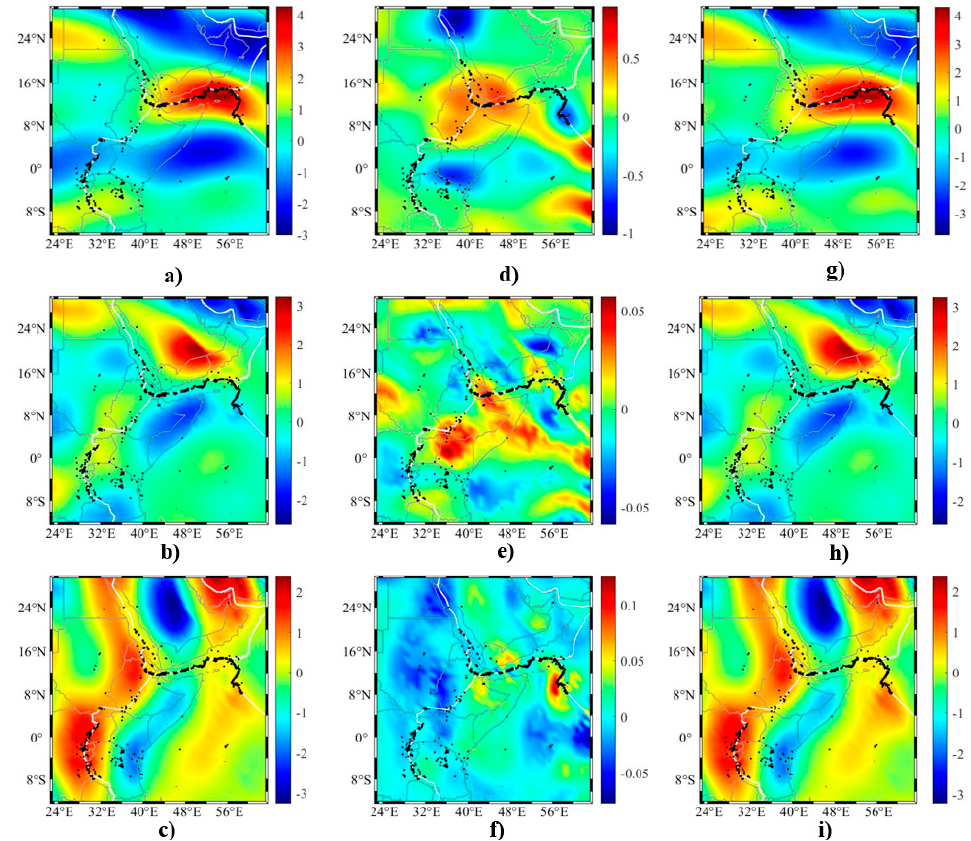
τ τ τ , ( b ) xz , and ( c ) yz from the τ τ , ( e ) xz , and ( f ) τ τ , ( h ) xz , and ( i )